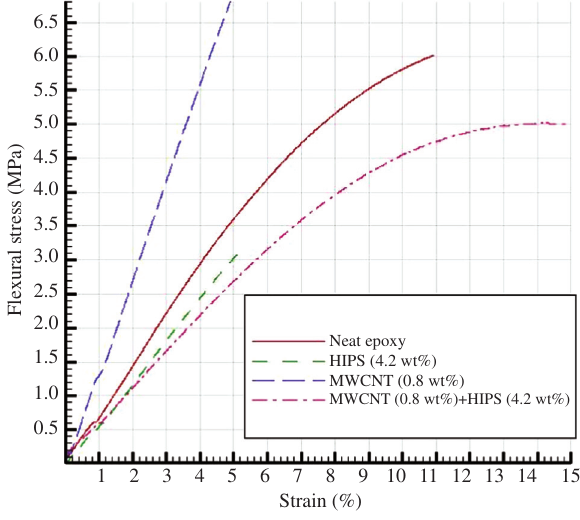
Figure 4 Stress-strain plot of the flexural